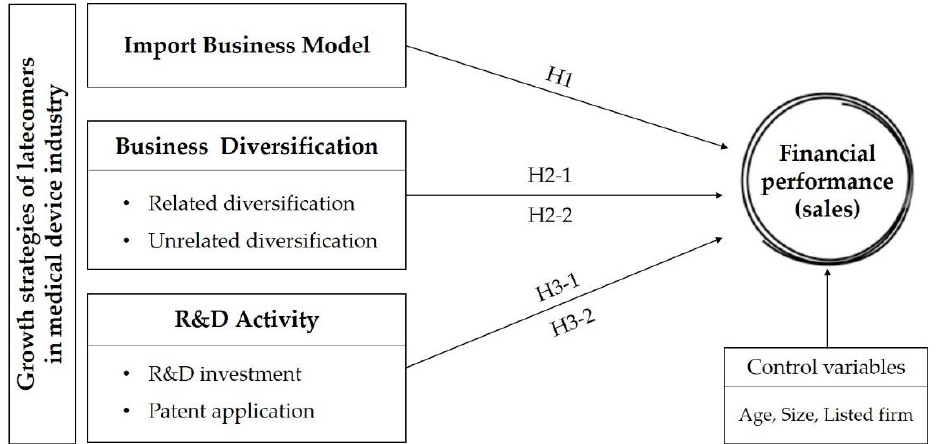
Figure 1. Schematic diagram of research model.